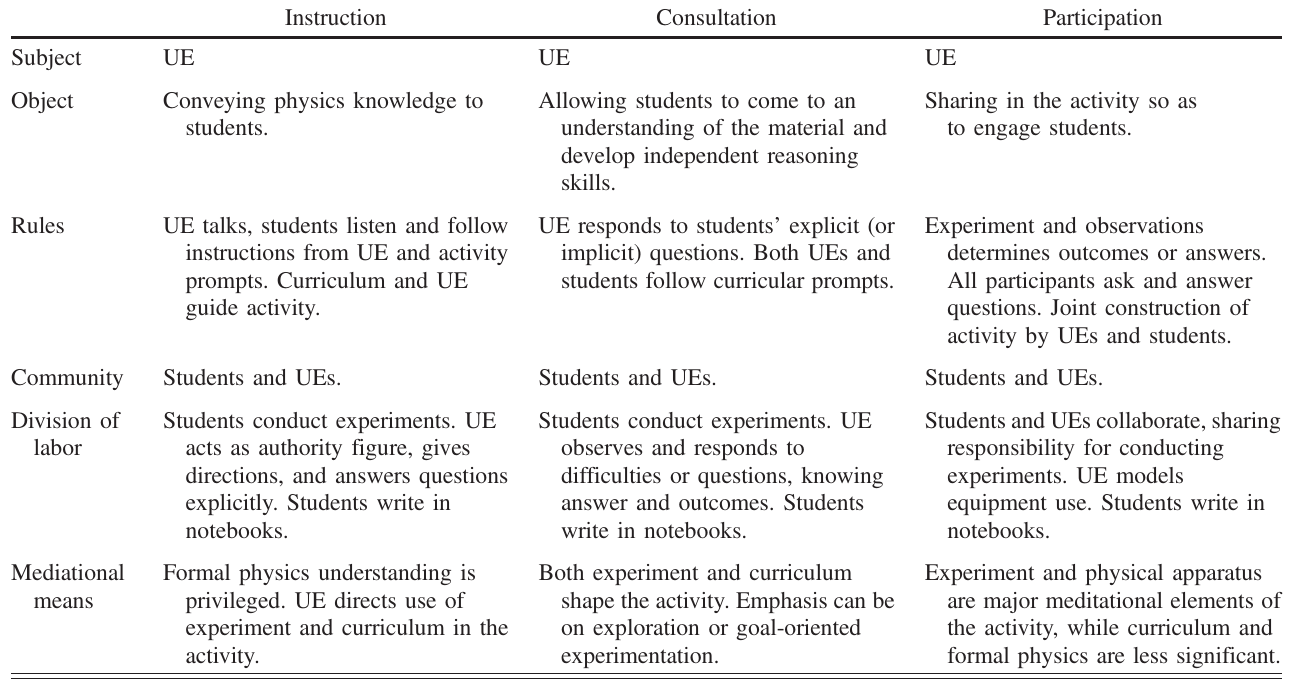
TABLE I. Activity theoretic comparison of pedagogical